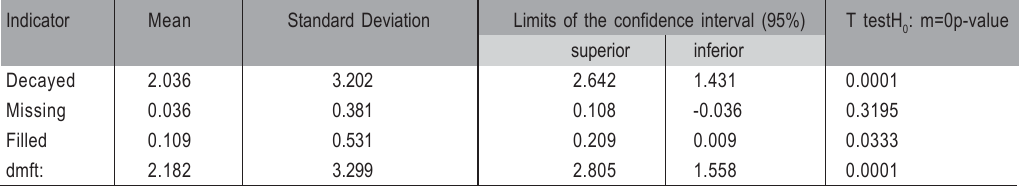
Table 1. Mean value, standard deviation, limits of the confidence interval and p value calculated from Student t-test to test the hypothesis that the mean value is 0 (n=110).